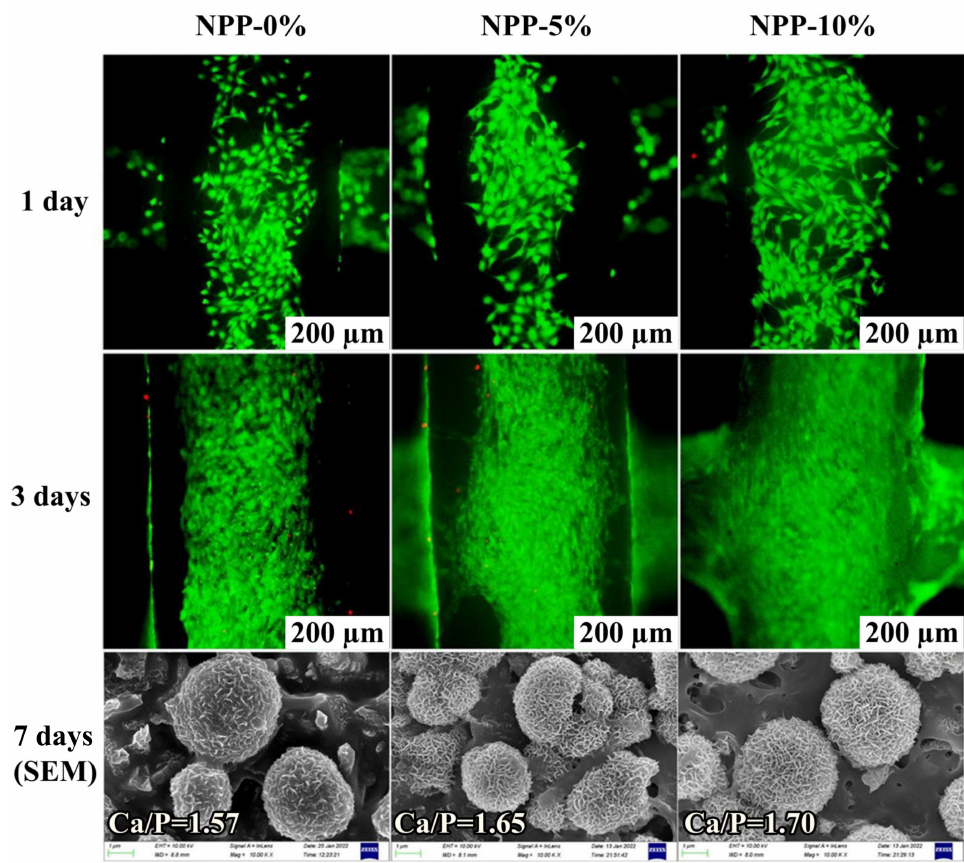
Figure 8. Cytocompatibility of different NPP scaffolds by co-culturing with MC3T3-E1 cells: live/dead staining; green fluorescence indicates viable cells and red fluorescence indicates dead cells. SEM images of the NPP-0%, NPP-5% and NPP-10% scaffolds after soaking in SBF for 7 days. Ca/P ratio obtained via EDS analysis. Reprinted with permission from Haihuan Gong; Yanyan Zhao; Qiwei Chen; Yilin Wang; Hong Zhao; Jing Zhong; Qing Lan; Ying Jiang; Wenhua Huang J. Mater. Chem. B 2022 , 10 , 8502–8513